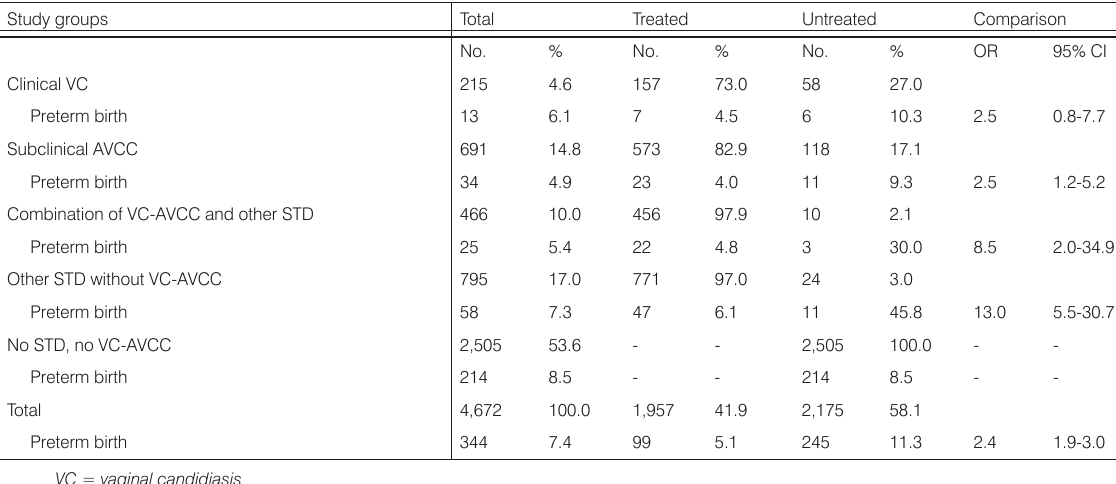
Table 3. The data of different study groups with or without treatment and the rate of preterm